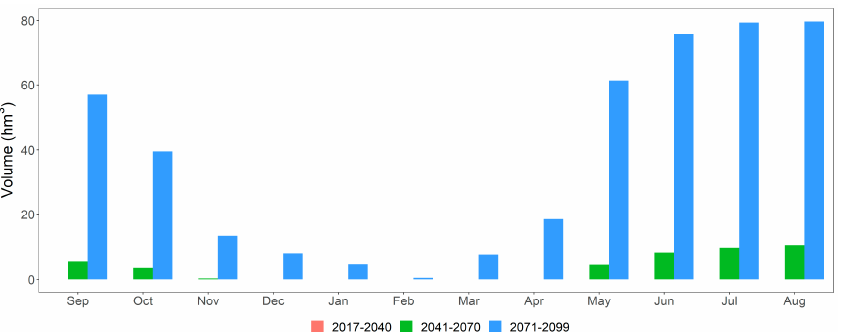
Figure 14. Monthly unmet demand for Scenario 1 in the VUB region for the period (2017–2099).